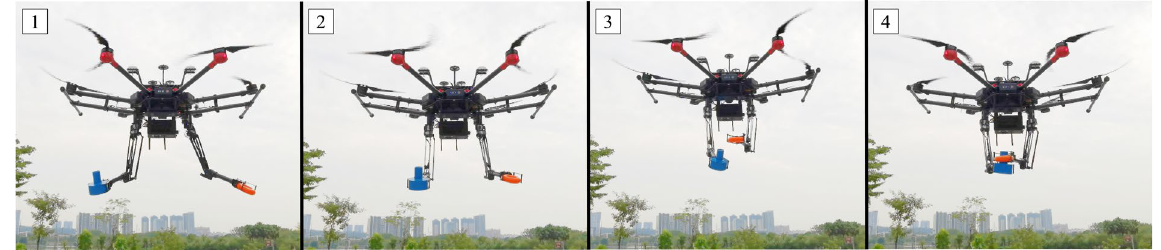
Figure 20. Image sequence of dual-arm cooperative manipulation test in outdoor.